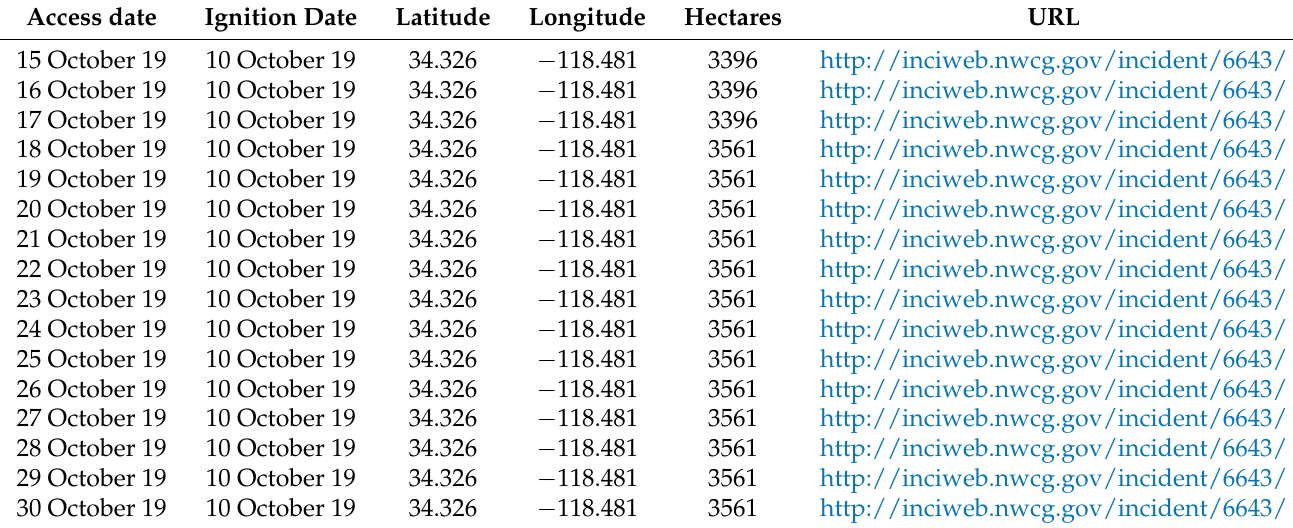
Table 1. InciWeb master dataset for the Saddleridge fire